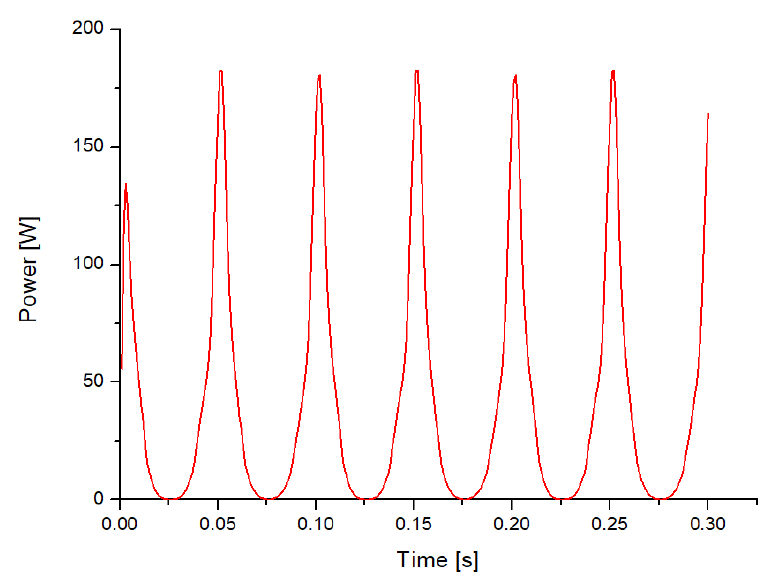
Figure 1. End-e ff